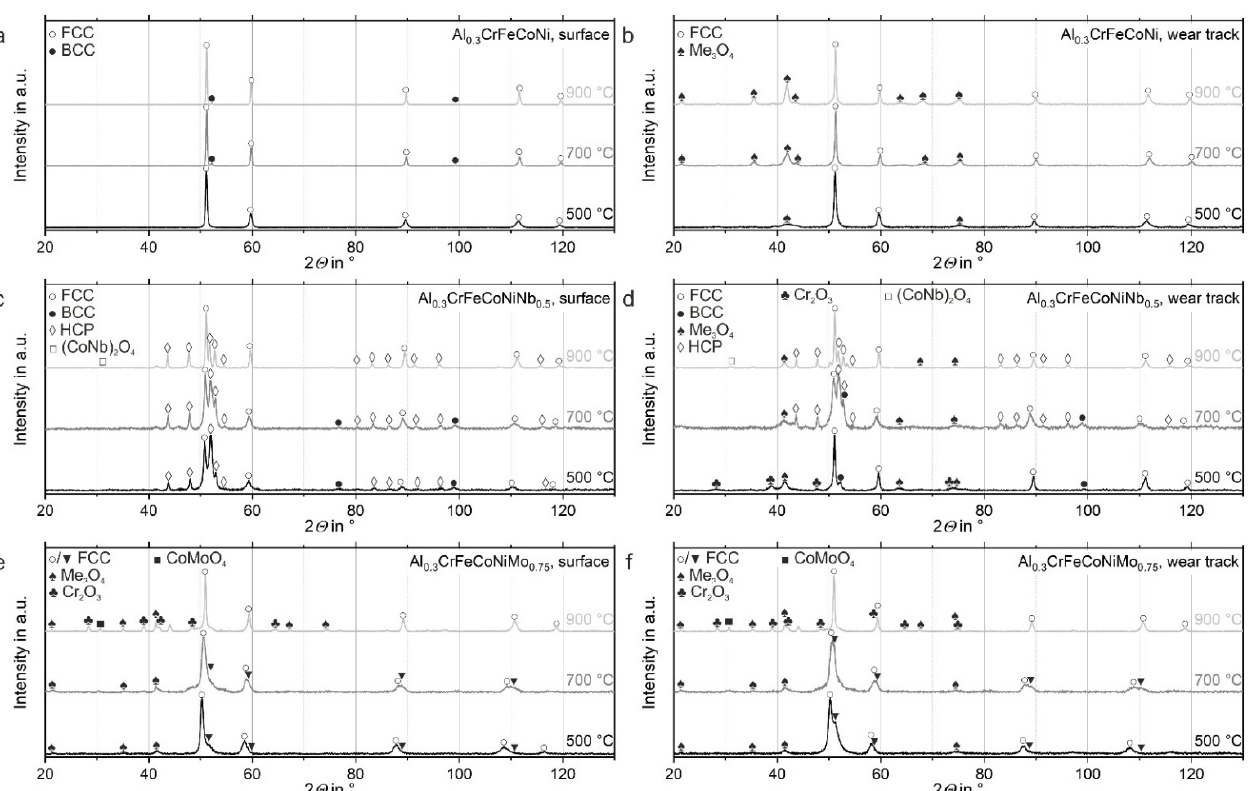
Figure 6. XRD diffractograms of the ( a , c , e ) surface and ( b , d , f ) wear tracks of HVOF-sprayed ( a , b ) Al 0.3 CrFeCoNi, ( c , d ) Al 0.3 CrFeCoNiNb 0.5 and ( e , f ) Al 0.3 CrFeCoNiMo 0.75 after high-temperature wear tests. In particular, metal oxides are formed in the wear tracks of HVOF-sprayed Al 0.3 CrfeCoNi ( b ) and Al 0.3 CrFeCoNiNb 0.5 ( d ). Only the HVOF-sprayed Al 0.3 CrFeCoNiMo 0.75 coating exhibits the same phases on the surface ( e ) and in the wear tracks ( f ) for all temperatures tested.